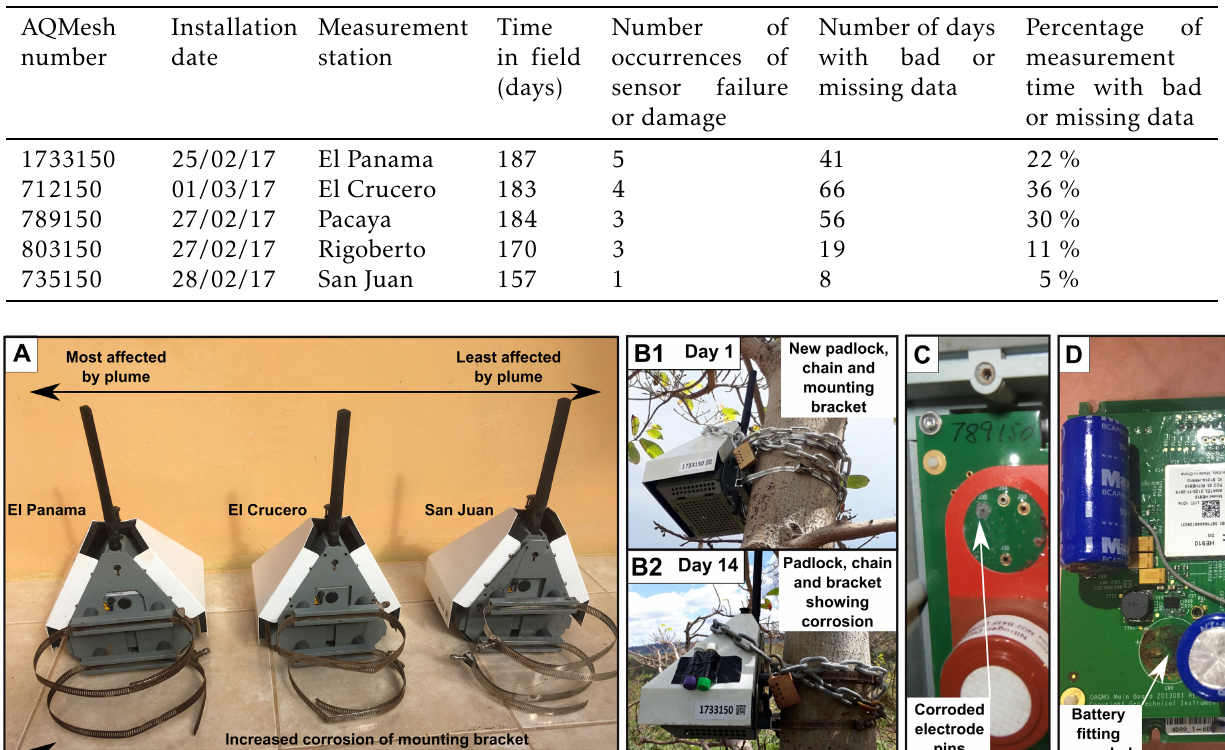
Table 2: Frequency of AQMesh pods being offline due to sensor failure or corrosion of key components impacting ability to function.